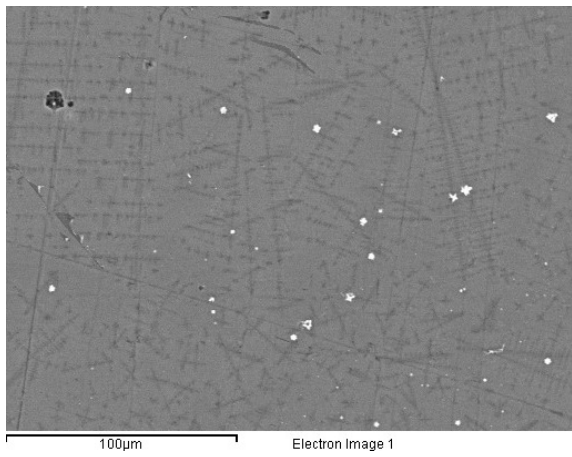
Figure 6. Details of crystals morphology after reaction lasted for 10 min.